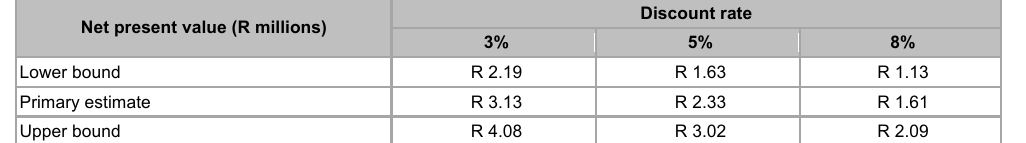
Upper and lower bound estimates of the costs of conventional adaptation through feed supplements and borehole construction Net present value (R